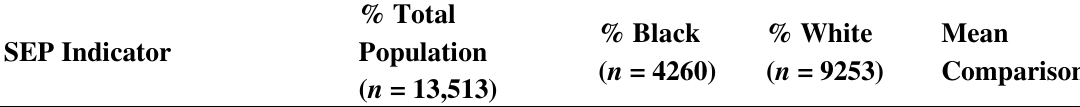
Table A1. Distribution of SEP measures by